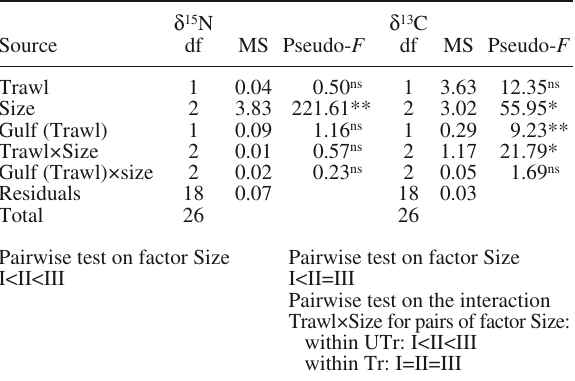
Table 4. – Results of univariate PERMANOVA based on the Eu- clidean distance of untransformed δ 15 N and δ 13 C data of hake for each area and size class, based on the sampling design illustrated in the text (by 9999 permutations). *, P <0.05; **, P <0.01; n.s.,